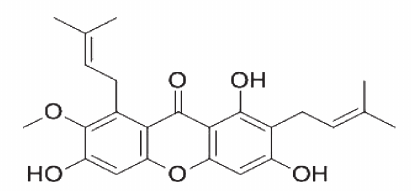
Figure 1. Chemical structure of α - mangostin (MY Ibrahim et al., 2014)